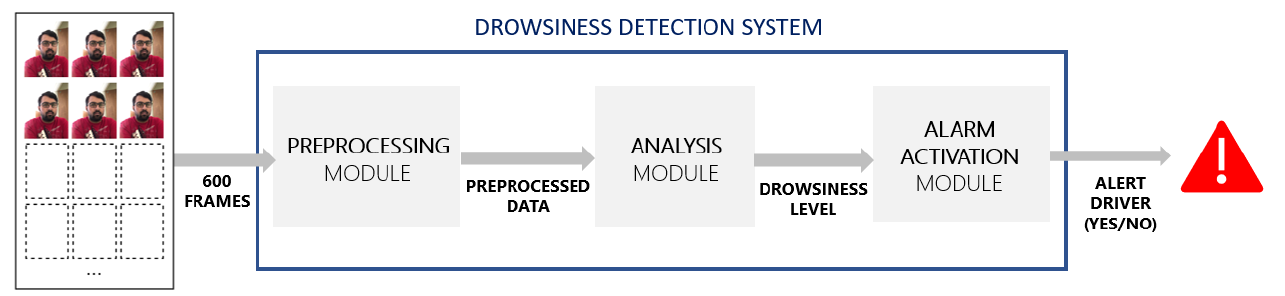
Figure 1. System